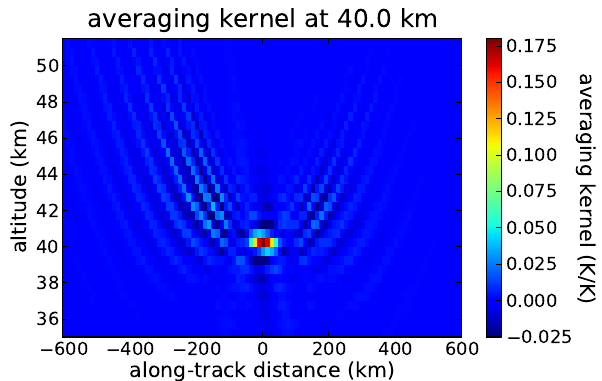
Fig. 7. Shown is the measurement contribution for a baseline re- trieval with no modulated wave structure (i.e. the atmosphere of Fig. 5a). Tangent points of measurements lie between ≈ 10km and 55km vertically and ≈ 500km and 5500km